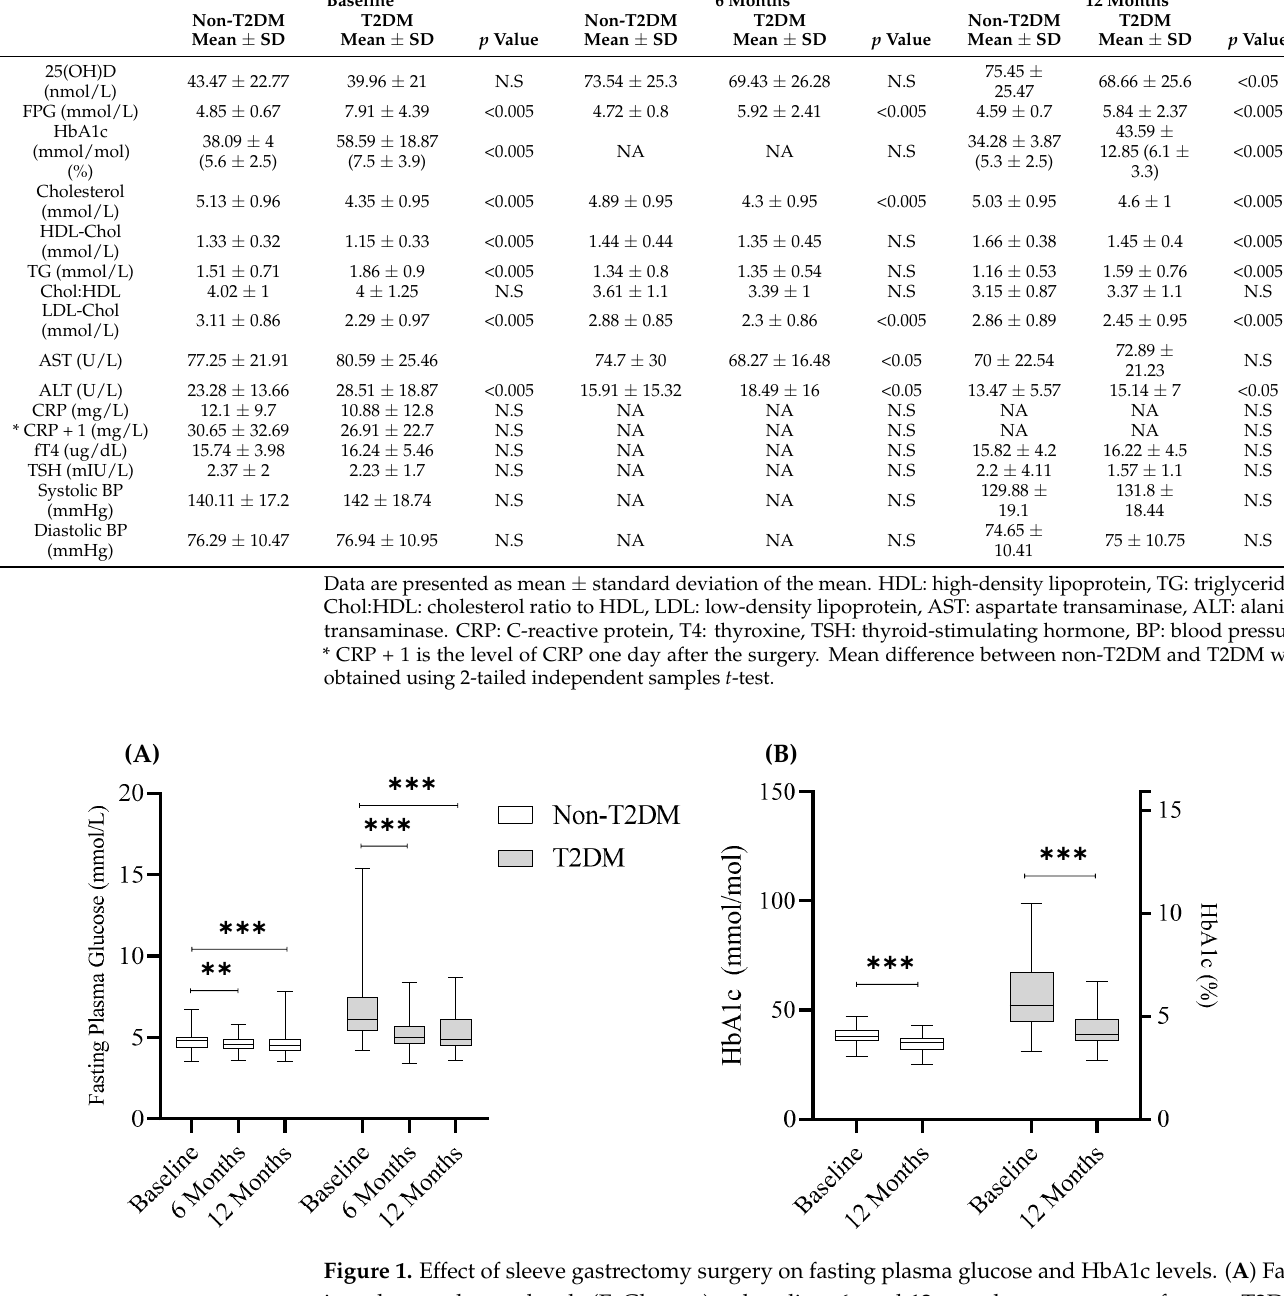
Figure 1. Effect of sleeve gastrectomy surgery on fasting plasma glucose and HbA1c levels. ( A ) Fast- ing plasma glucose levels (F. Glucose) at baseline, 6- and 12-months post-surgery for non-T2DM and T2DM groups. ( B ) Serum HbA1c levels at baseline and 12-months post-surgery for non-T2DM and T2DM groups. Data are presented as mean ± standard error of the mean. Statistical differences between time points were determined via a 2-tailed paired t -test: ** p < 0.01, *** p <